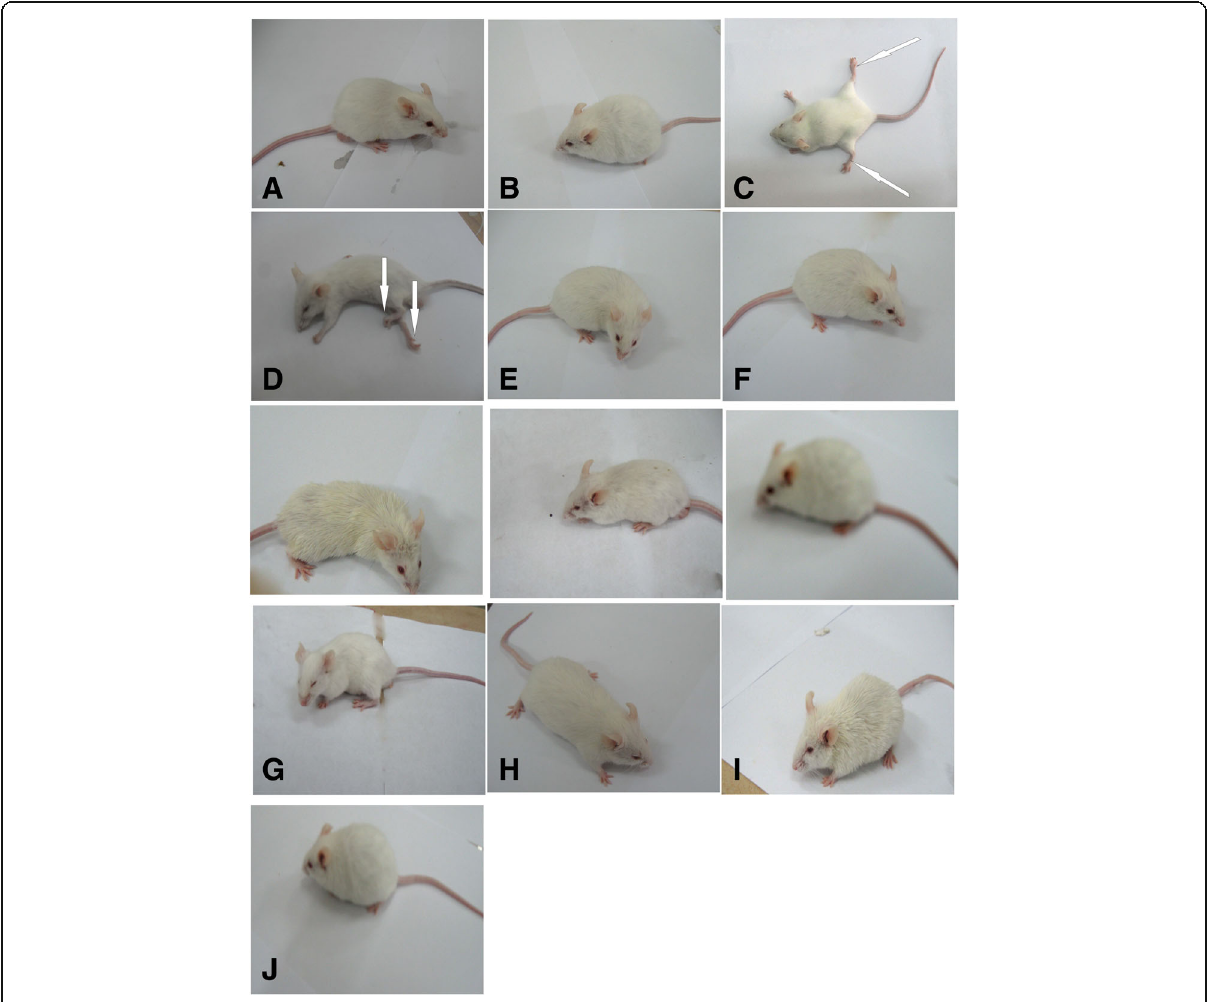
Fig. 3 Photographs showing induced weakness of limbs at 45 ( c ) and 60 days ( d ) of the acrylamide-administered group compared to the control ( a ) and acrylamide-administered group for 30 days ( b ). The chips feeding groups ( e – g ), bee venom group ( h ), and BPF- ( i ) treated group showed normal movement and gait. The combined groups of treatments with bee venom ( j ) or with BPF showed improvement in movement and gait as compared with the acrylamide-administered group ( k – m ). Arrows indicate dislocated limbs in acrylamide administration at 45 and 60